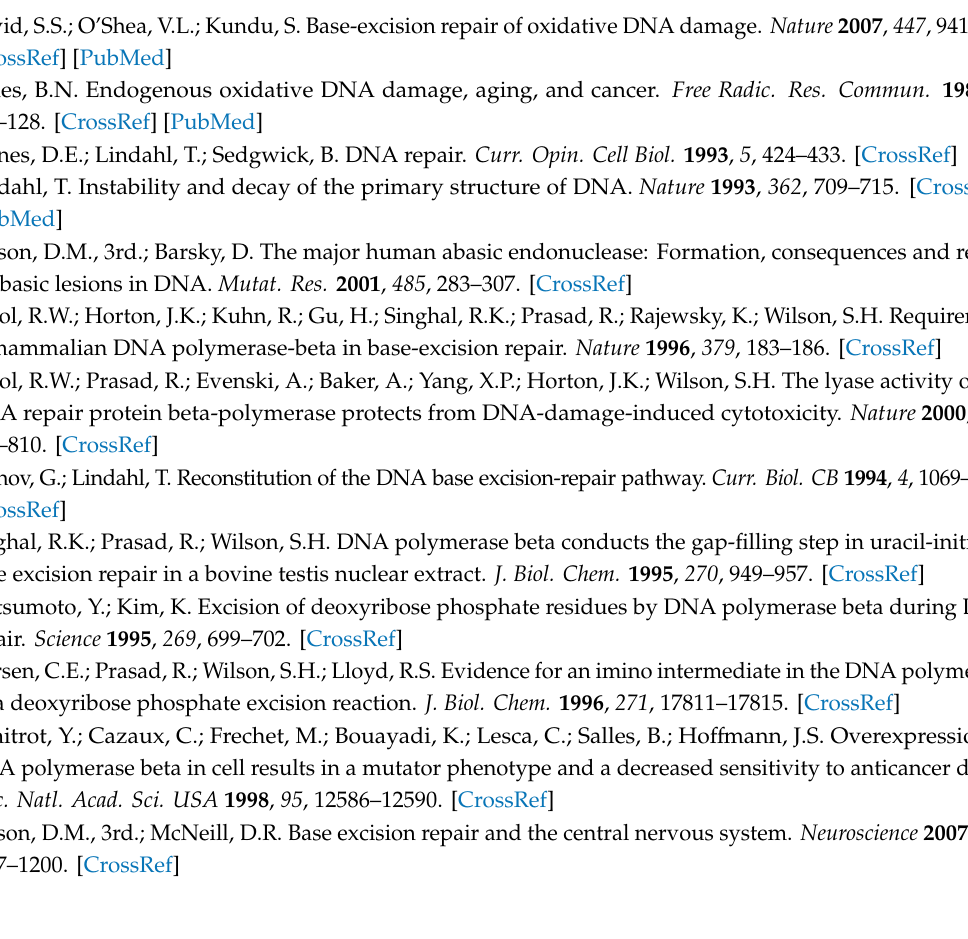
Figure S1: Mutation in POLB moderately increase apoptosis; Figure S2: Image of Western blots; Table S1: list of primers; Table S2: List of